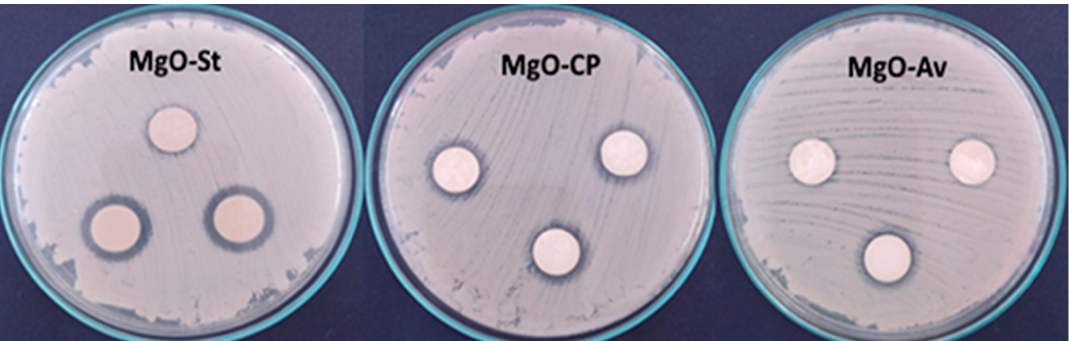
Figure 4. Photographs of halos of inhibition formed in tests against C. Albicans using the oxide samples MgO-St, MgO-CP, and MgO-Av. The oxide MgO-St showed the largest halo of inhibition. Table 2. Average mean zones of inhibition (in mm) produced by synthesized MgO samples on the test